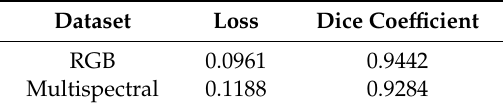
Table 3. Model average